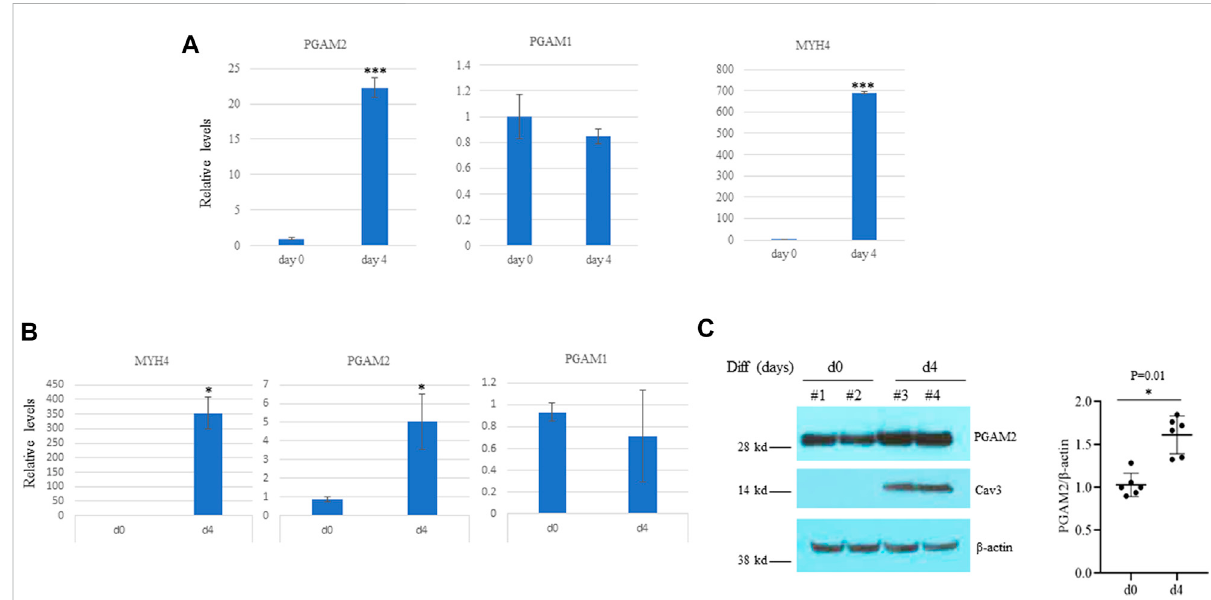
FIGURE 2 PGAM2 expression is increased during myogenic differentiation. (A) Results of RNA sequencing analysis showing that the expression of PGAM2 but not PGAM1 was signi fi cantly increased at differentiation day (d)4 when compared with d0. The increased expression of MHC4 at d4 compared with d0 was used as a positive control. n = 3 per group. **** p < 0.001 vs. d0. (B) Results of real-time PCR analysis of differentiating C2C12 cells at different days con fi rming increased PGAM2 expression during myogenic differentiation. n = 4 per group. * p < 0.05 vs. d0. (C) Protein levels